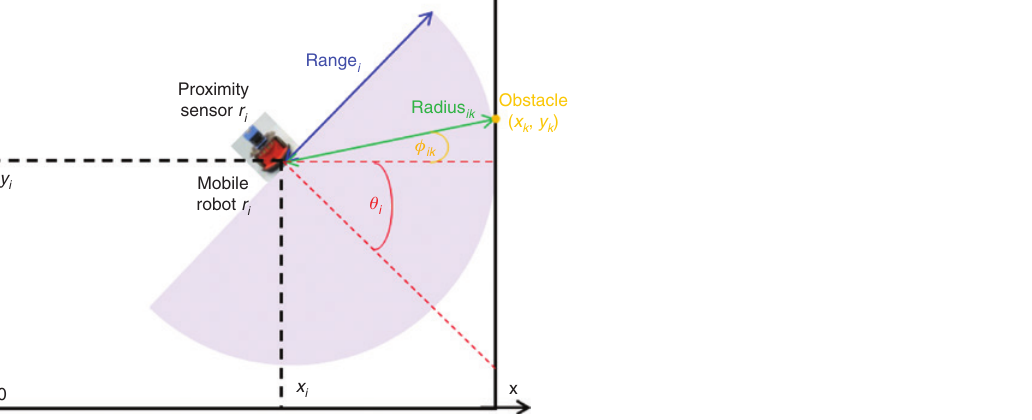
Figure 1: Obstacles and Environment Limits Detection and Calculation of their ( x Sensor of Robot r i